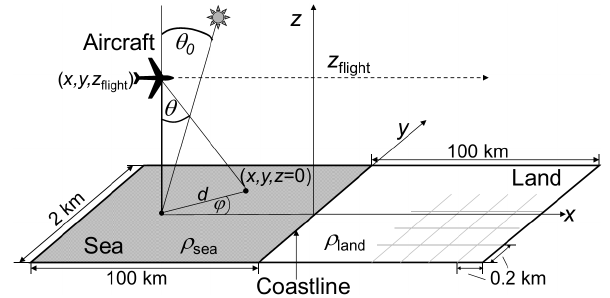
Fig. 1. Synthetic flight geometry with aircraft flying in altitude z flight . The aircraft flies perpendicular to the coastline at constant